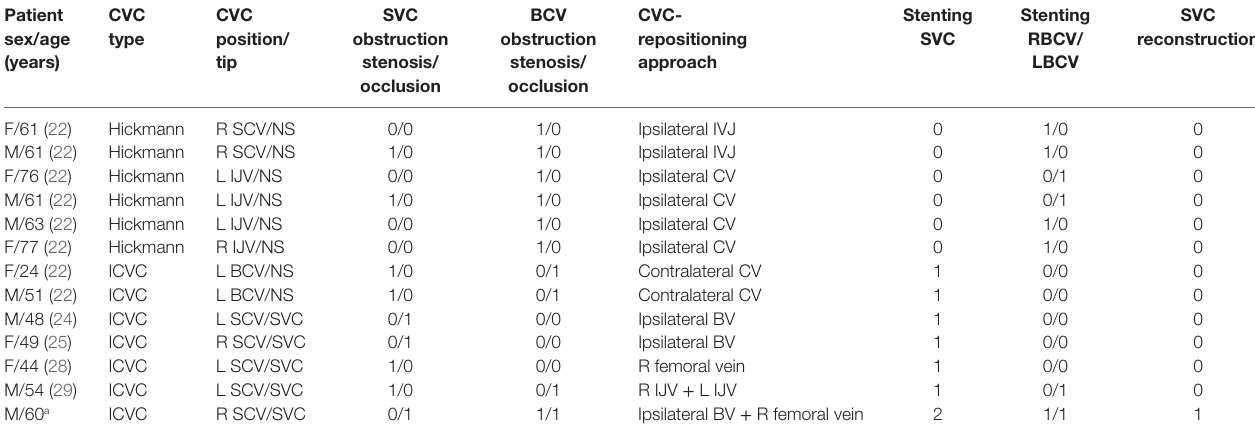
taBle 1 | Literature review of reported cases on technical differences of catheter repositioning during the treatment of SVC obstruction. patient